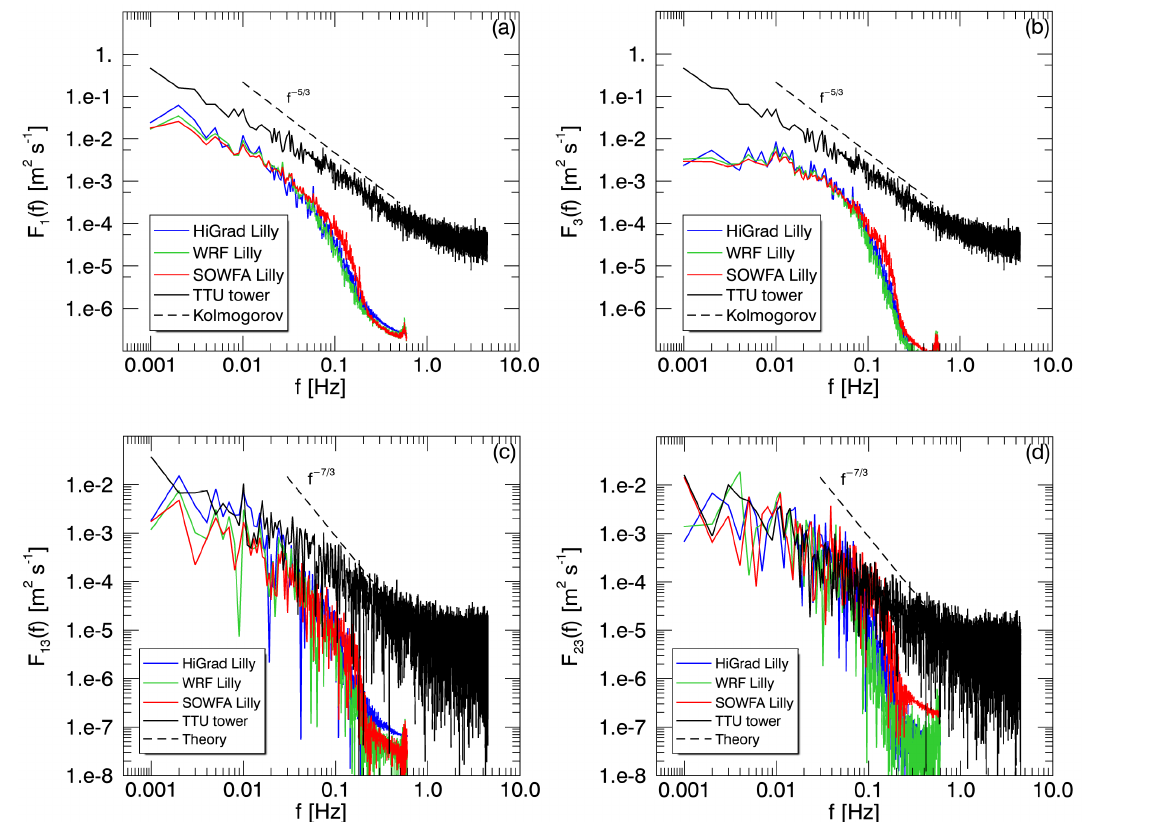
(cid:8) u (cid:48) w (cid:48) (cid:9) (c) and